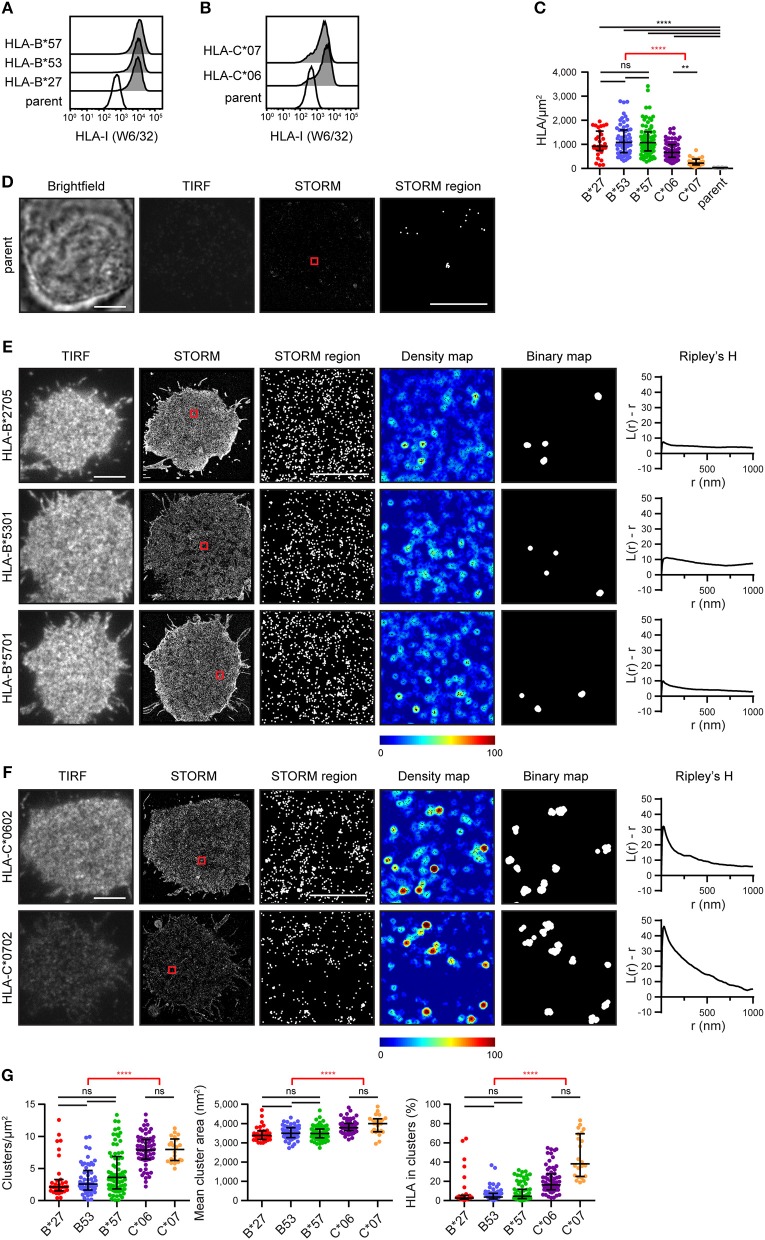
The nanoscale organization of different HLA-I allotypes. (A,B) Representative flow cytometry plots of 721.221 cells untransfected (“parent”; white histogram) or transfected to express (A) HLA-B or (B) HLA-C allotypes (gray histograms) stained for folded HLA-I. (C) The density of HLA-I in the membrane of transfected 721.221 cells when imaged by STORM. (D) Representative brightfield, TIRF microscopy and STORM images of 721.221 parent cells (scale bar: 5 μm). STORM panels show the Gaussian-rendered image of co-ordinate data. The 1 × 1 μm region (red box in STORM image) is enlarged and the corresponding scatter plot is displayed (STORM region; scale bar: 500 nm). (E) Representative TIRF microscopy and STORM images are shown for (E) HLA-B or (F) HLA-C allotypes (scale bar: 5 μm). STORM panels show the Gaussian-rendered image of co-ordinate data. The 1 × 1 μm regions (red boxes in STORM images) are enlarged and the corresponding scatter plots, density maps (G&F analysis) and binary maps are shown (scale bar: 500 nm). The Ripley's H function is plotted for that cell. (G) Quantitative analysis of nanoclusters. Each dot represents the mean value for a cell. Black bars show median and interquartile range. HLA-B*27 (red; 31 cells; 5 experiments); HLA-B*53 (blue; 58 cells; 10 experiments); HLA-B*57 (green; 71 cells; 11 experiments); HLA-C*06 (purple; 64 cells; 10 experiments); HLA-C*07 (orange; 22 cells; 5 experiments); parent (gray; 19 cells; 4 experiments). Kruskal-Wallis test with Dunn's multiple comparisons (black) and Mann Whitney test (for comparing all HLA-B v. HLA-C; red) (Graphpad Prism version7); **p < 0.01, ****p < 0.0001.